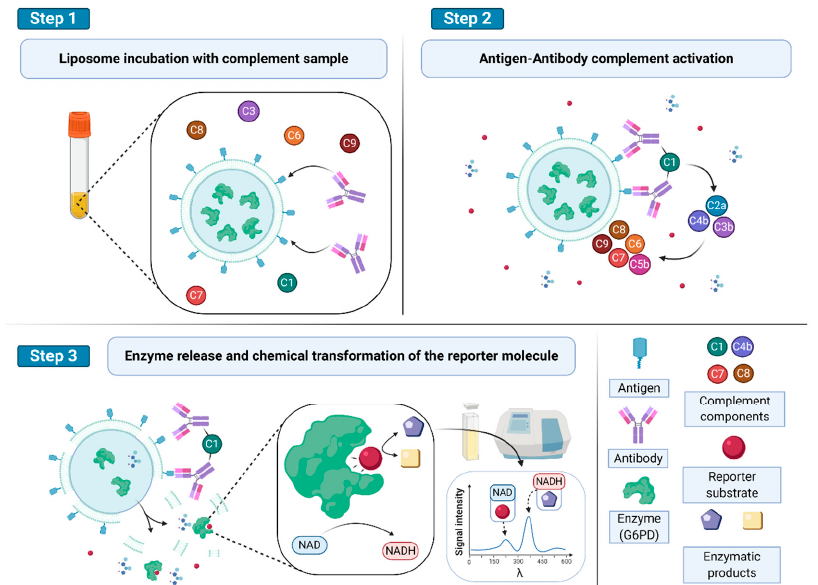
Figure 4. Detection of complement and antibody (Ab) activity in blood samples. ( Step 1 ) Abs, added or already present in the serum sample interact with liposome-bearing specific antigens (Ags) on their surfaces. ( Step 2 ) Complement is activated by the presence of the Ag–Ab interaction on the liposome surface. ( Step 3 ) Complement activity disrupts or alters the phospholipidic bilayer permeability, allowing the access of the reporter substrate to the enzyme. The cleaved substrate yields a detectable signal carrying information on the complement activity. Figure inspired by [38].